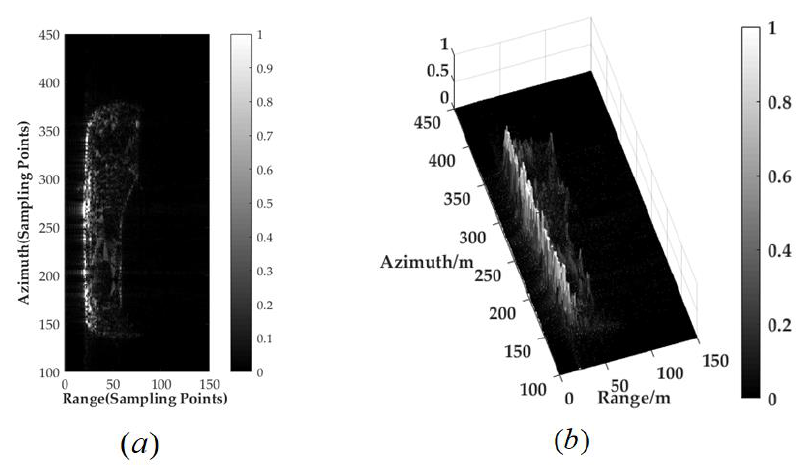
Figure 14. Simulated SAR image of car body: ( a ) magnitude image; ( b ) energy distribution.